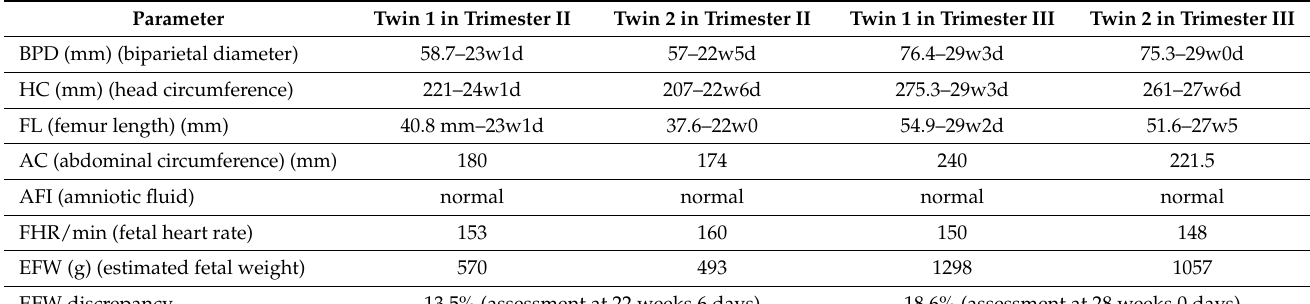
Table 3. Ultrasound growth patterns in the second and third